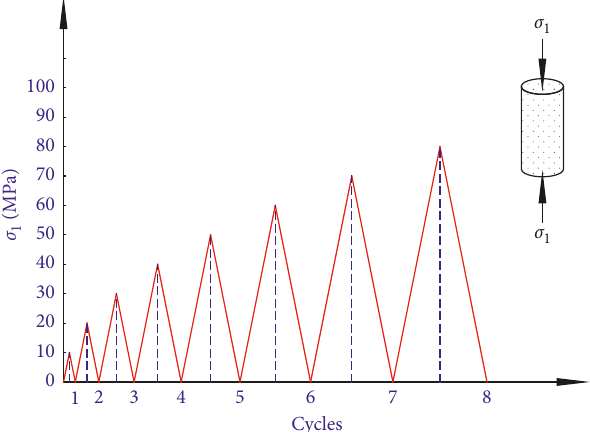
Figure 1: Stress path of the uniaxial loading and unloading test.